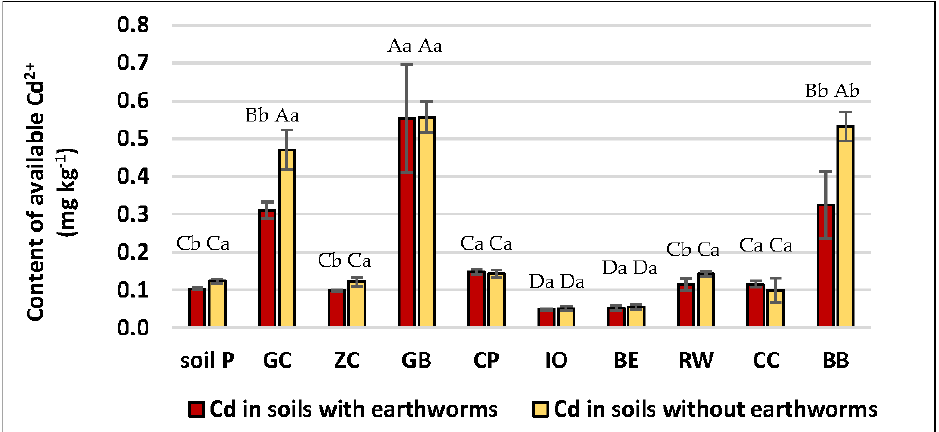
Figure 4. Content of extractable Cd in soils affected by soil amendments and earthworm activity. Different lower case letters within the same type of amendment application indicate significant differences between individual Cd concentration in soils with and without earthworms, while capital letters indicate significant differences between applied amendments (ZC-Zabrze compost, GC-GWDA compost, BB- Bełchatów biosolids, GB -Grabów biosolids, CP-Calcium phosphate, IO-Iron oxide, BE-Bentonite, RW-Rock waste, CC-Limestone; ANOVA, Mann-Whitney test, p < 0.05).